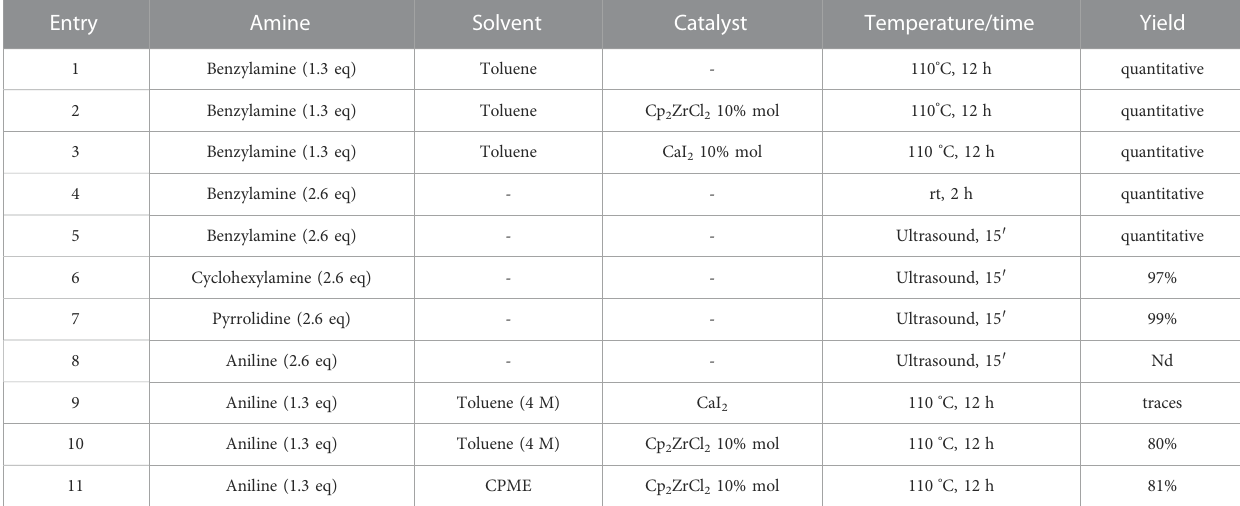
TABLE 3 Optimized conditions for the direct amidation of methyl 4-oxo-4,5-dihydro [1,2,3]triazolo [1,5- a ]quinoxaline-3-carboxylate.